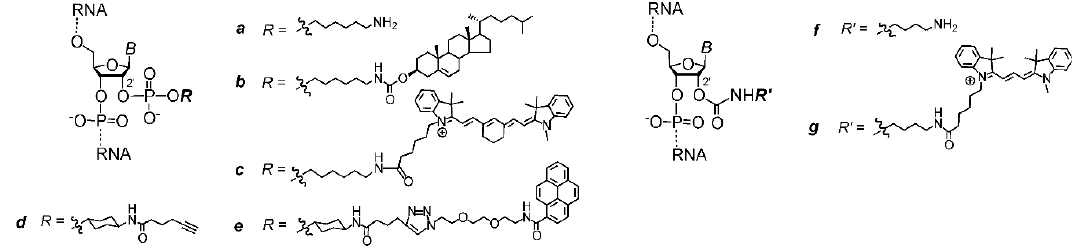
Figure 4. Chemical structure of 2’ modified nucleosides ( N* ).